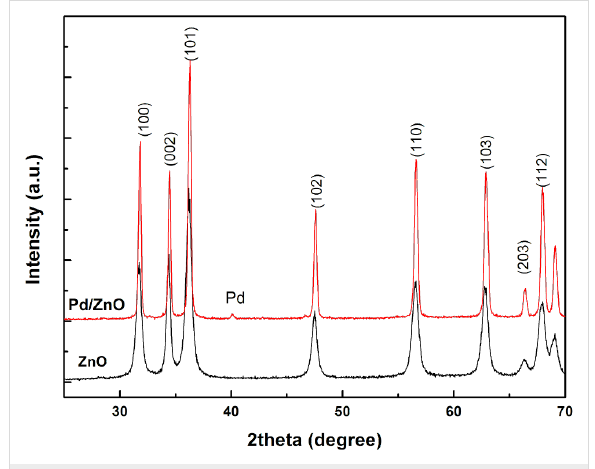
Figure 1: X-ray diffraction patterns of ZnO and Pd/ZnO nanopowders.